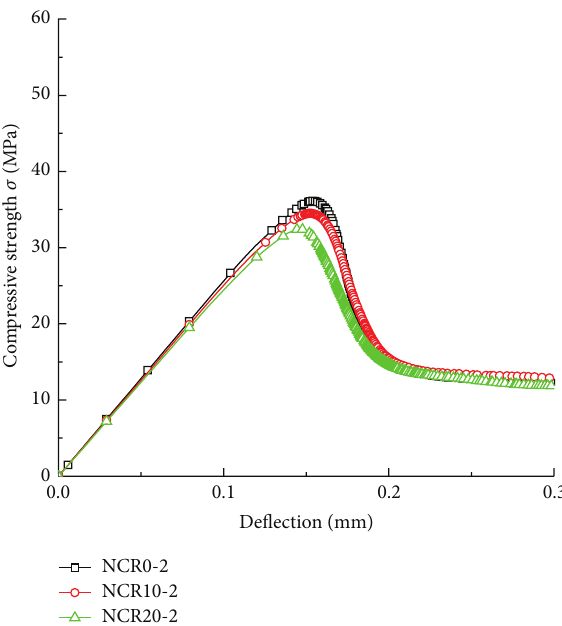
Figure 6: Load displacement 𝑃 - 𝛿 curve for various rubber contents without taking into account the interface layer.